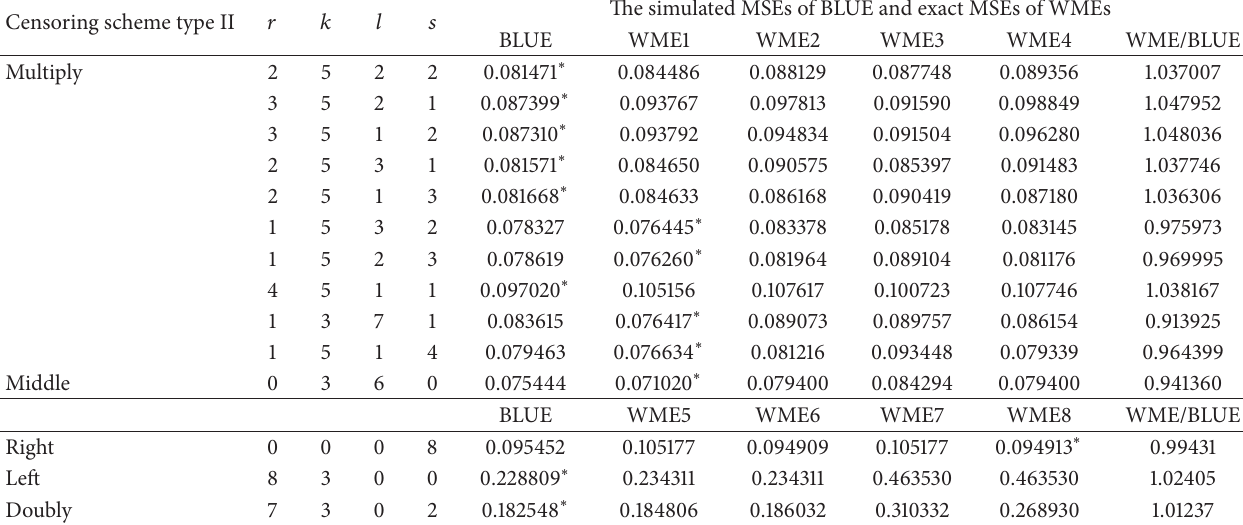
Table 3: MSEs of BLUE and WMEs of the location parameter 𝜃 at 𝑁 = 15 , 𝜎 = 1.0 , and 𝜃 = 1 .